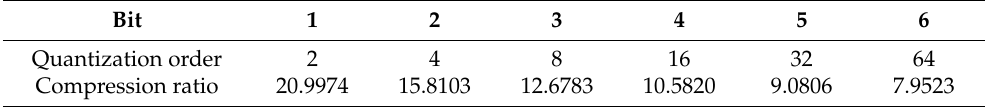
Table 2. Quantization order correspondence.